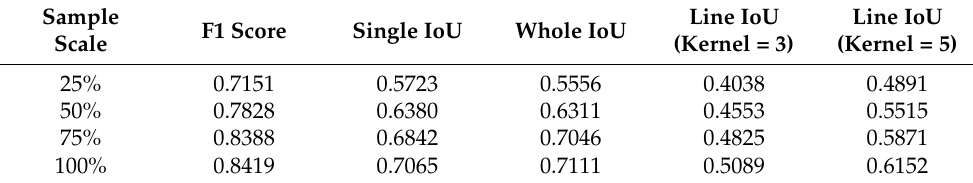
Table 1. Precision evaluation results for the effect of the sample scale in the supervised method.